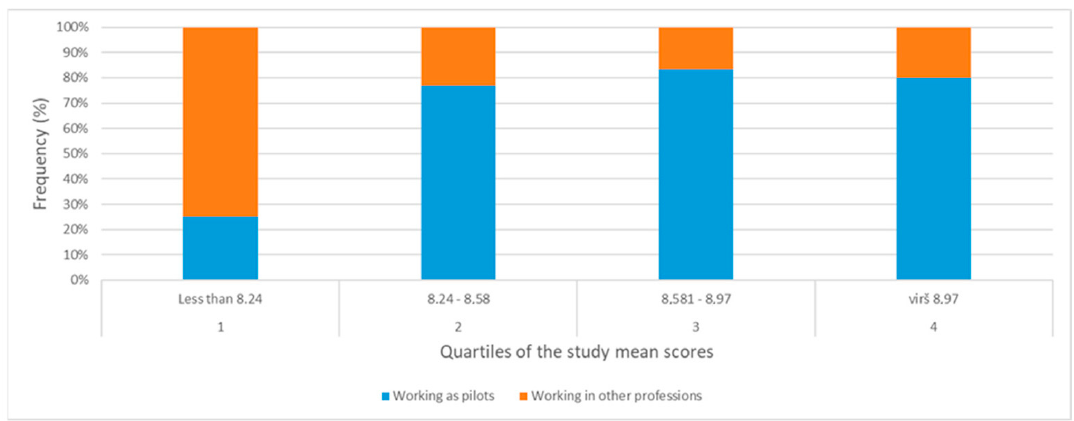
Figure 6. Frequency of employment as pilots according to the quartiles of the mean study scores (source: created by the authors) .